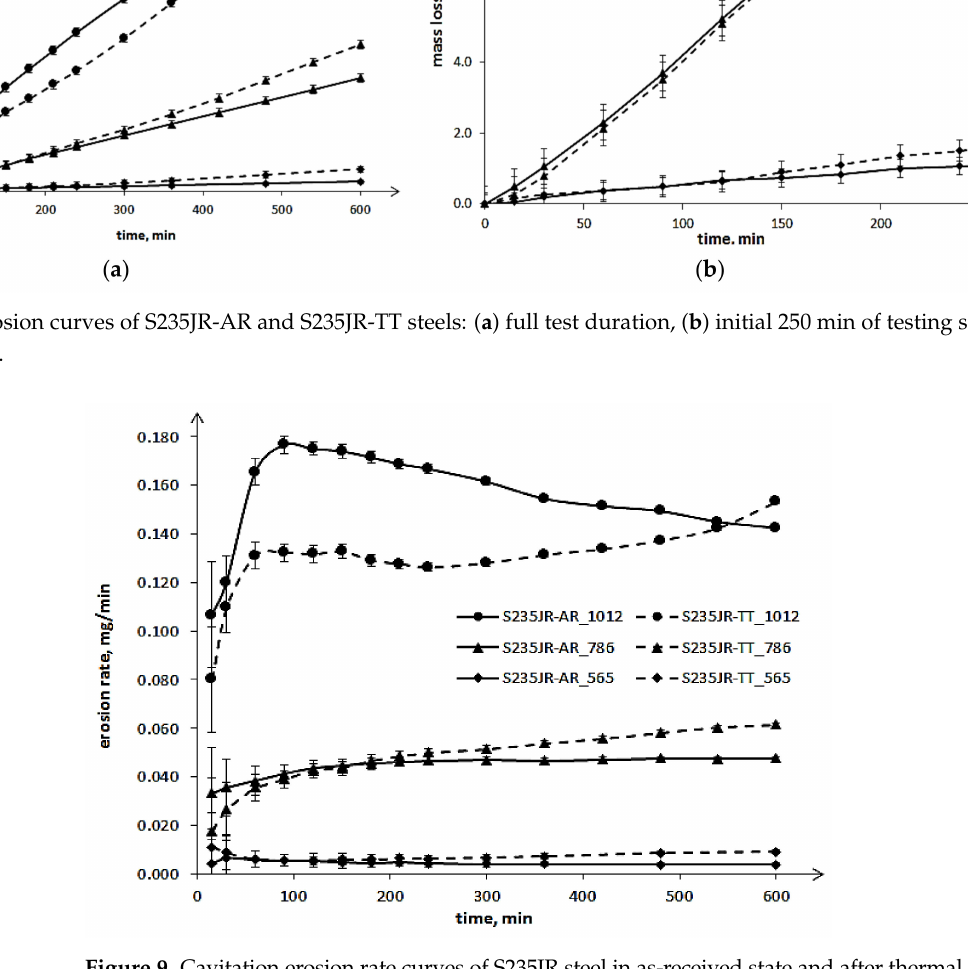
Figure 9. Cavitation erosion rate curves of S235JR steel in as-received state and after thermal